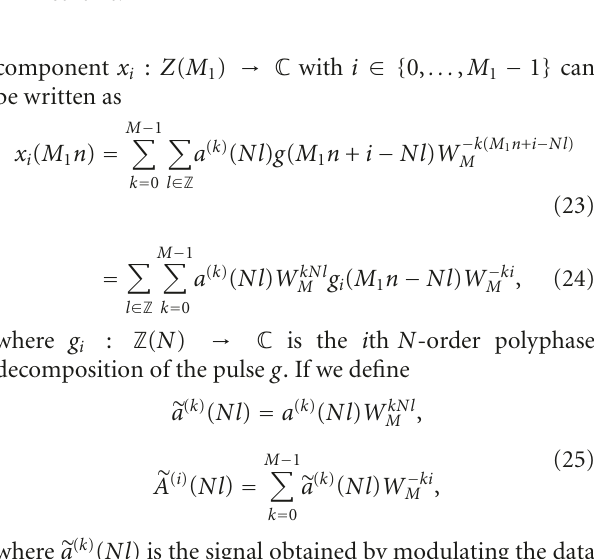
Figure 1: Modified FMT